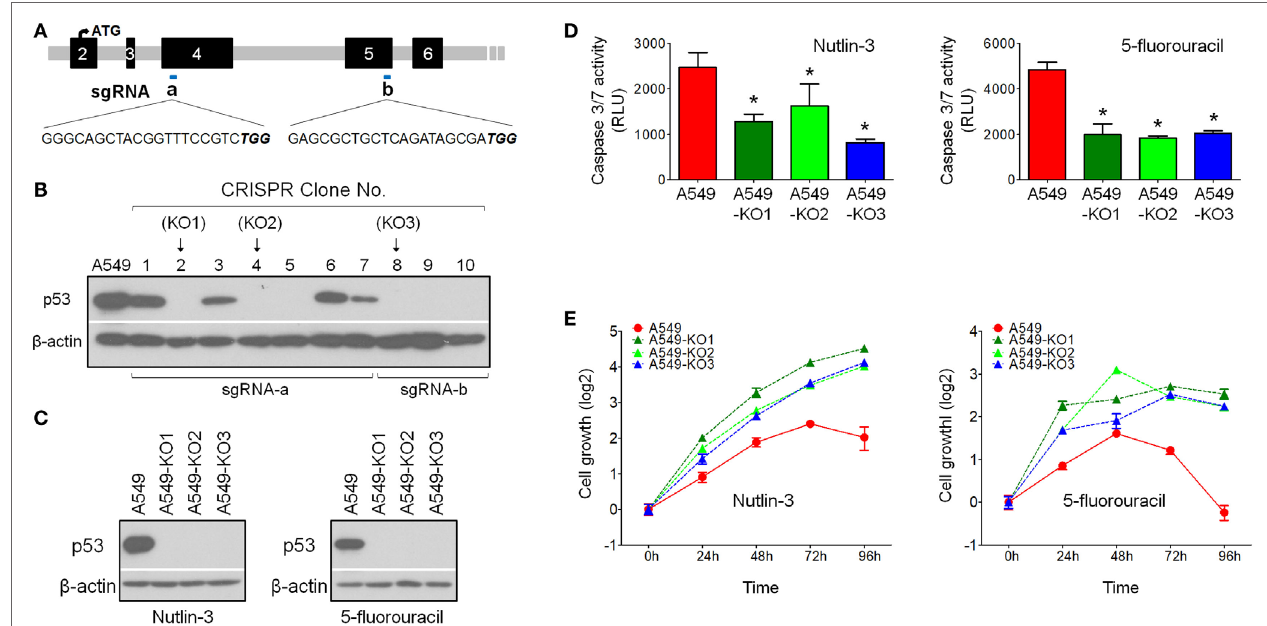
FigUre 1 | Generation of p53null A549 cells by CRISPR/Cas9 technology. (a) Single-guide RNA (sgRNA) sequence designed to target p53WT for gene knockout by CRISPR/Cas9 technology. (B) Western blot screening of p53 protein expression in CRISPR A549 cell clones. (c) Western blot analysis confirmed loss of p53 protein expression in p53null cell clones A549-KO1, A549-KO2, and A549-KO3. Cells were pretreated with either Nutlin-3 or 5-fluorouracil to induce p53 accumulation in A549 cells. (D) Caspase 3/7 assay indicated that all p53null CRISPR clones had lower caspase activity compared with p53WT A549 cells in response to 4 h treatment of Nutlin-3 (25 µM, left panel) or 5-fluorouracil (50 µg/ml, right panel). * p < 0.05. (e) WST-1 cell proliferation assay indicated that the three selected p53null CRISPR clones were resistant to Nutlin-3 (15 µM, left panel) or 5-fluorouracil (30 µg/ml, right panel) induced growth inhibition/cell